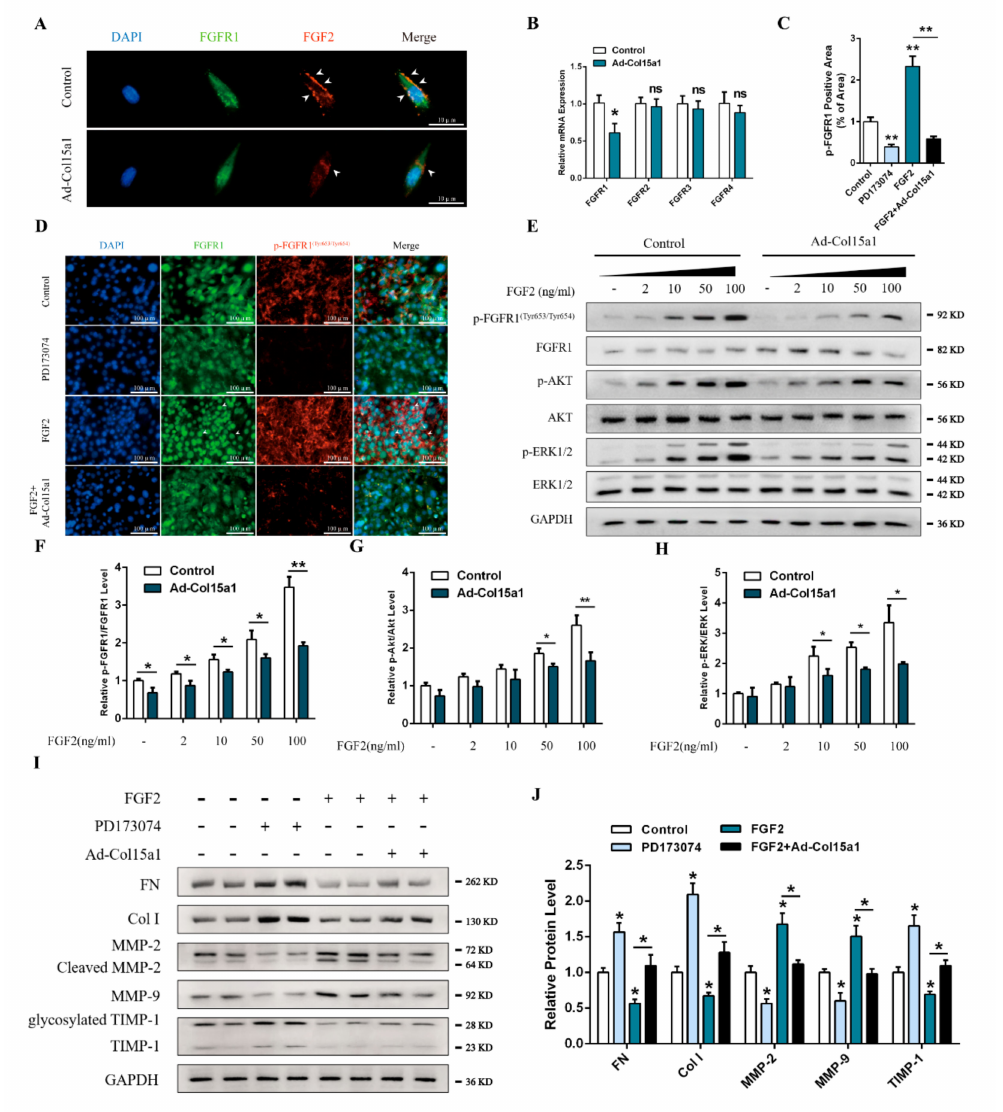
Figure 7. ColXV promoted ECM deposition in adipose tissue via fibroblast growth factor 2 (FGF2) / fibroblast growth factor receptor 1 (FGFR1) axis. ( A ) Representative images of adipocytes in di ff erent groups stained by FGFR1 (green) and FGF2 (red). Arrowheads indicate FGF2 enriched to the cell membrane. Scale bar, 10 µ m. ( B ) Relative mRNA levels of FGFR1, FGFR2, FGFR3, and FGFR4 of adipocytes in di ff erent groups ( n = 4). ( C - D ) Representative images of adipocytes in di ff erent groups were stained by FGFR1 (green) and p-FGFR1 Tyr653 / Tyr654 (red). Arrowheads indicate FGFR1 transferred into the nucleus. Scale bar, 100 µ m ( n = 4). ( E – H ) Relative protein phosphorylation levels of FGFR1 Tyr653 / Tyr654 , AKT, and ERK1 / 2 of two groups in adipocytes with gradients concentration